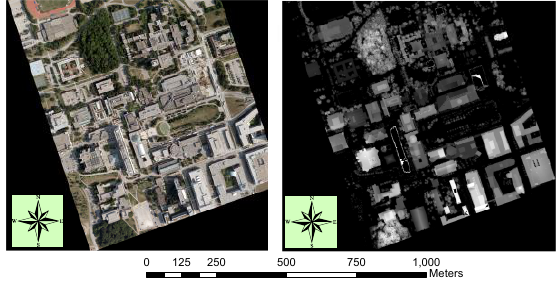
Figure 1. The true colour composite VHR imagery (left) and LiDAR CHM (right) covering the Keele campus of York University (Site 1) (43.77165°N, 79.501321°W).